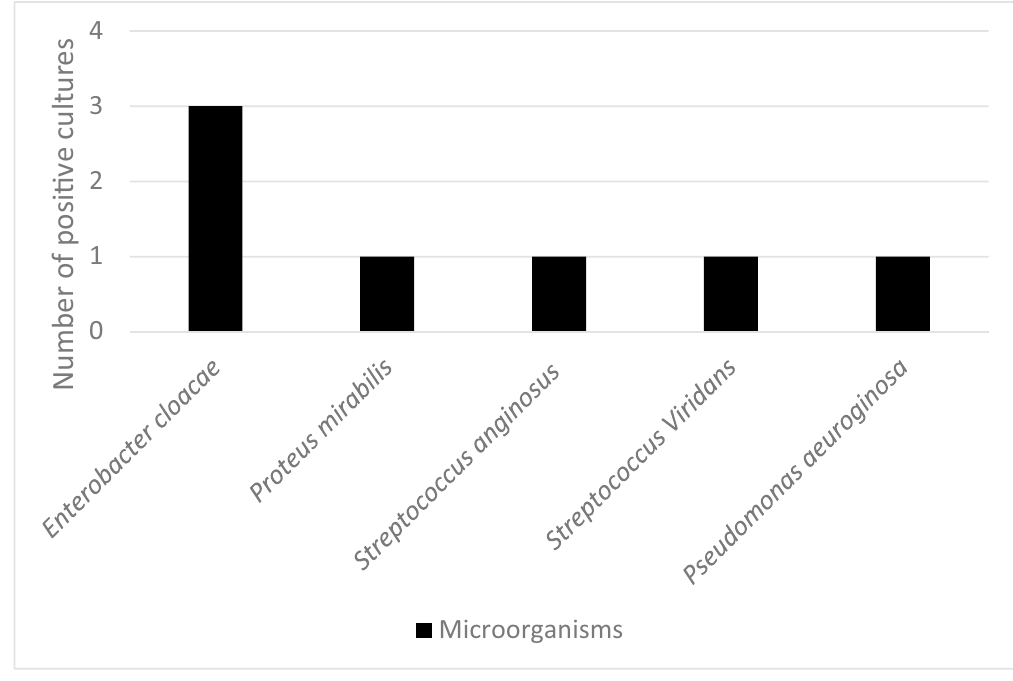
Figure 2. Surgical Site Infection